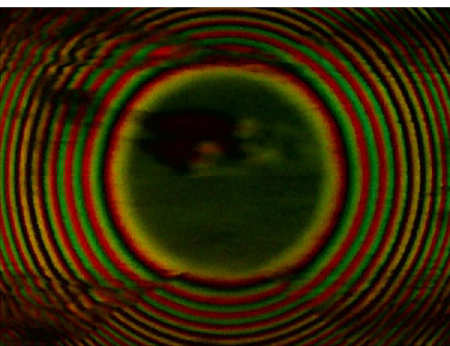
Fig. 23 Interferograms and scratch of glass disk at 100th cycle under pure rolling reciprocating motion (Centoplex 2EP, v max = 0.04 m/s, w = 15 N, T = 0.5 s, L = 5